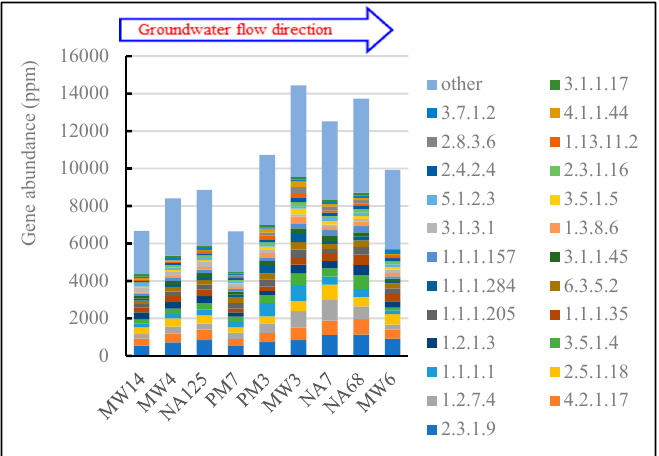
Figure 6. Abundance of genes involved in xenobiotic biodegradation and metabolism.